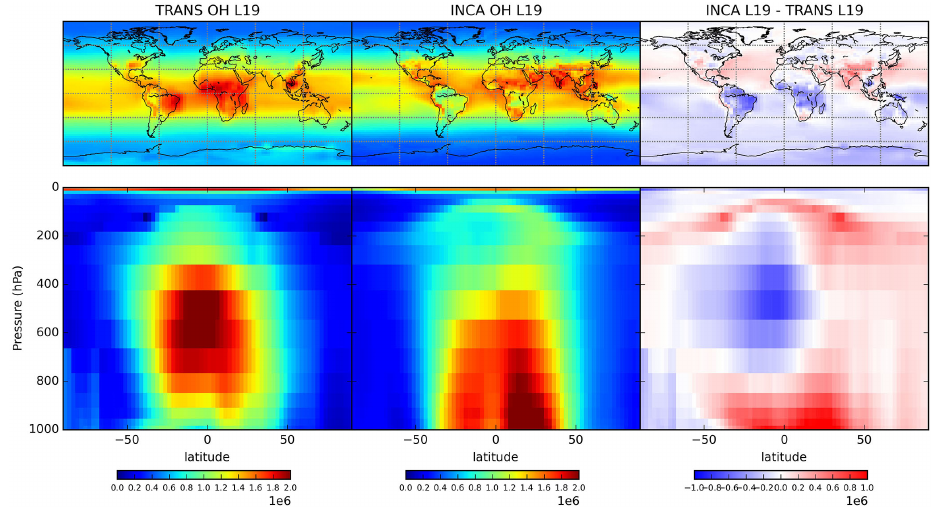
Figure 3. Spatial and vertical distribution of OH concentration in TransCom and INCA and their relative differences. The TransCom OH is interpolated from its original 60 pressure levels into the LMDz 19 eta-pressure